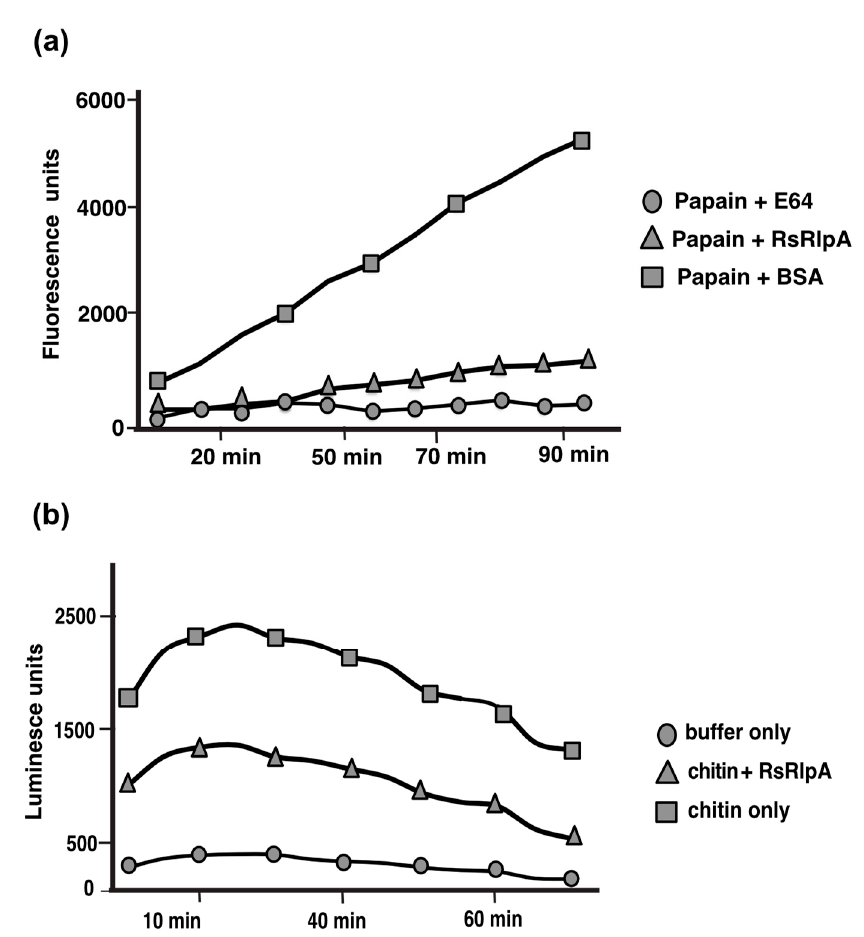
Figure 5. The RsRplA is a protease inhibitor suppressing ROS burst. ( a ) Protease inhibition assay using 10 µ M of purified RsRlpA protein mixed with the Z-Phe-Arg-NMec substrate and 5 µ M papain. The protease inhibitor E64 and BSA protein were used as positive and negative controls, respectively. ( b ) Chitin-induced oxidative (ROS) burst assay in N. benthamiana leaves. Production of ROS was determined using luminol-dependent chemiluminescence. Leaf discs were treated with chitin, 10 µ M RsRplA protein, while only bu ff er was used as a negative control. Eight biological replicates were run in both